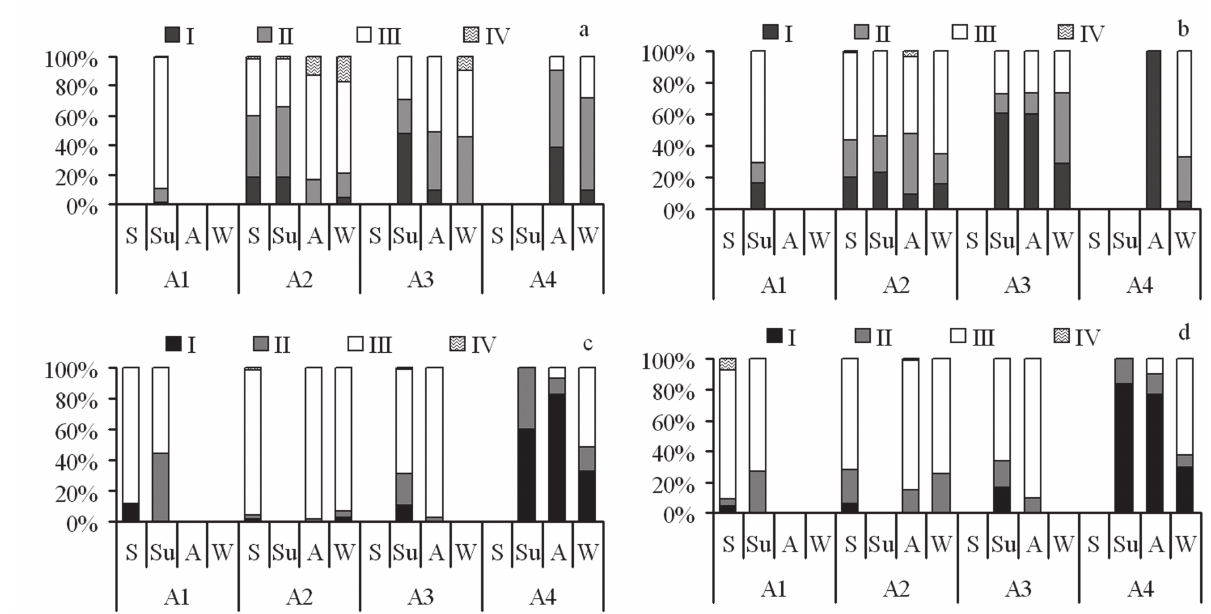
Fig. 7 . – Importance of maturity stages of L. plei by depth strata (A1, A2, A3 and A4) in (S) spring, (Su) summer, (A) autumn and (W) winter. (a) males and (b) females of L. plei and (c) males and (d) females of L. sanpaulensis . Depth strata are those presented in Fig. 4.